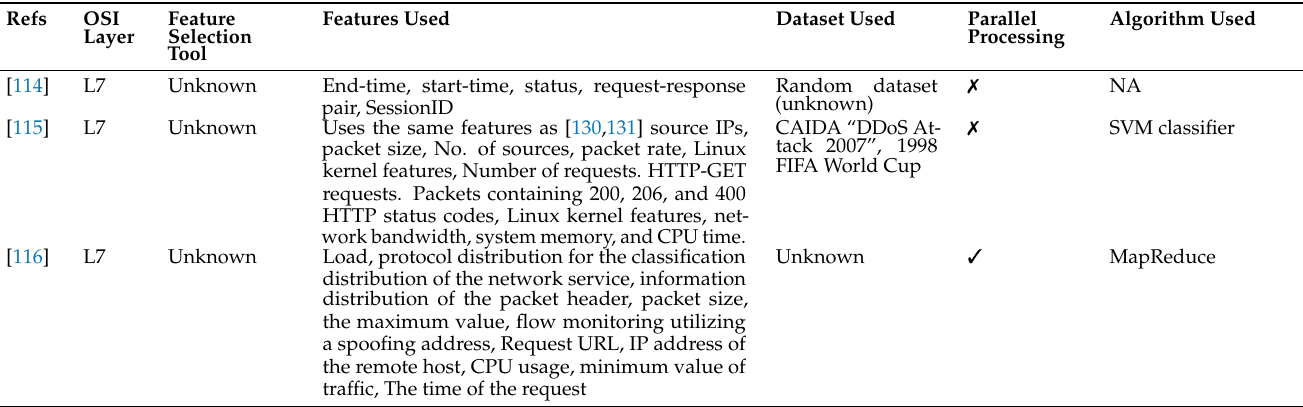
Table 10. Anomaly-based Detection